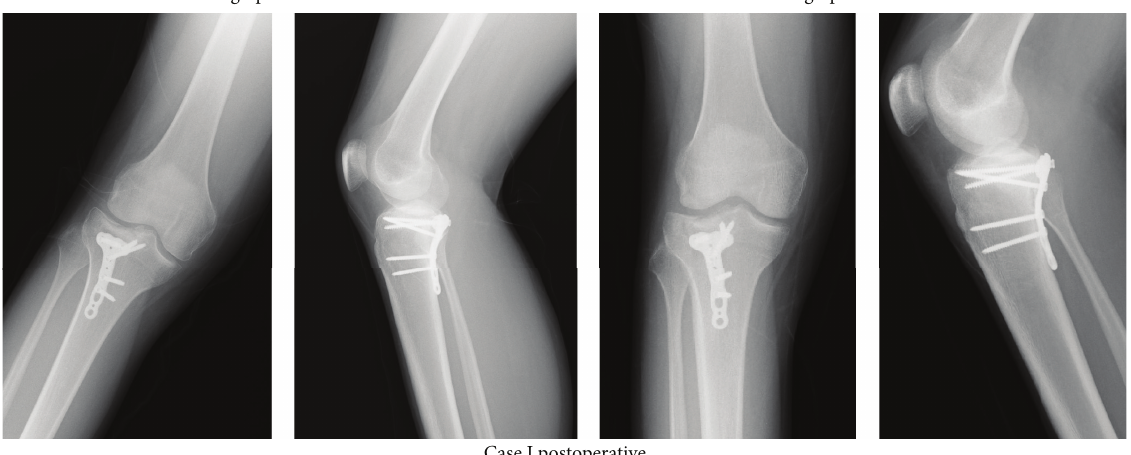
Figure 4: Postoperative radiographies of Case